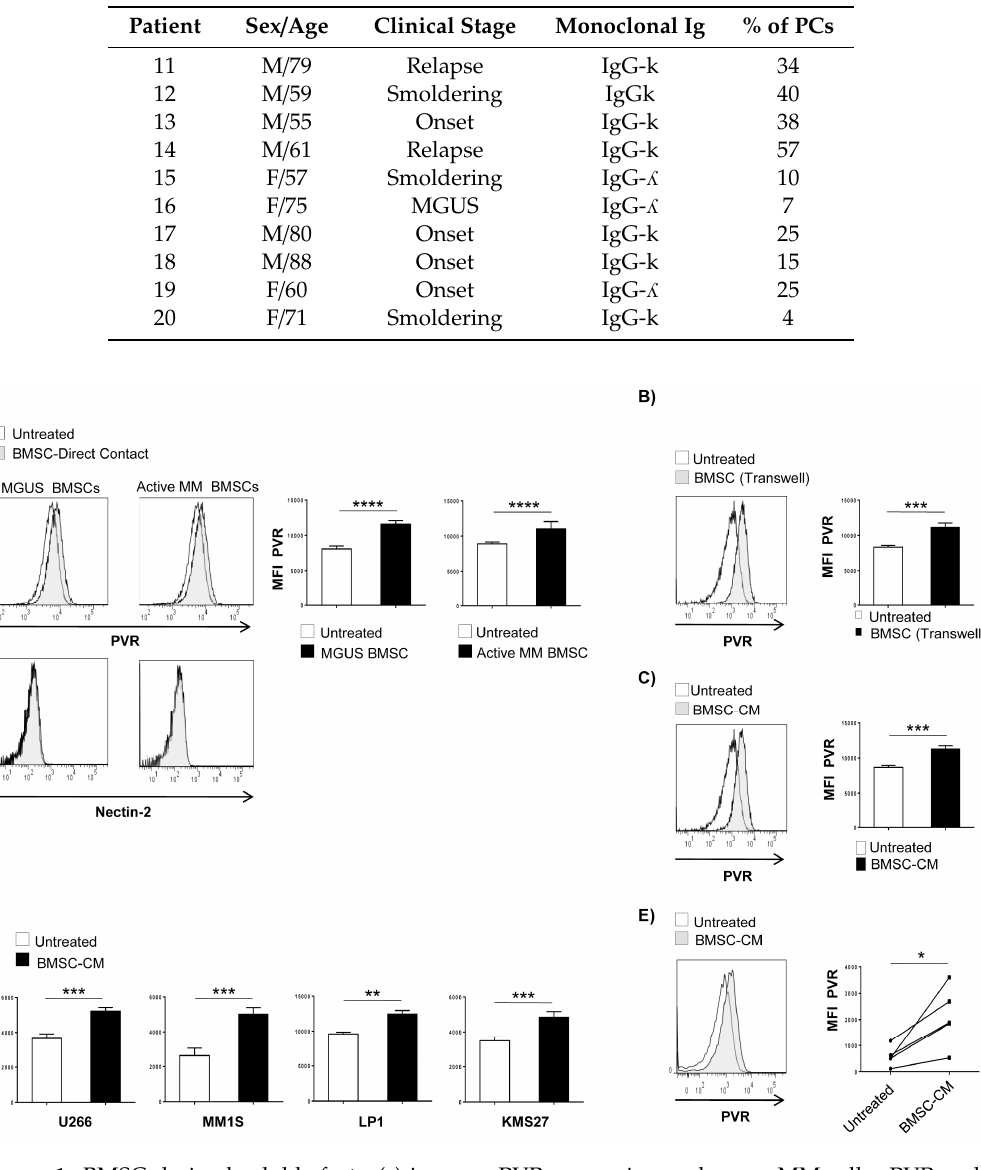
Table 1. Clinical parameters of MM patients used for the analysis of PVR surface expression and mRNA. Patients were classified according to Durie and Salmon’s Staging